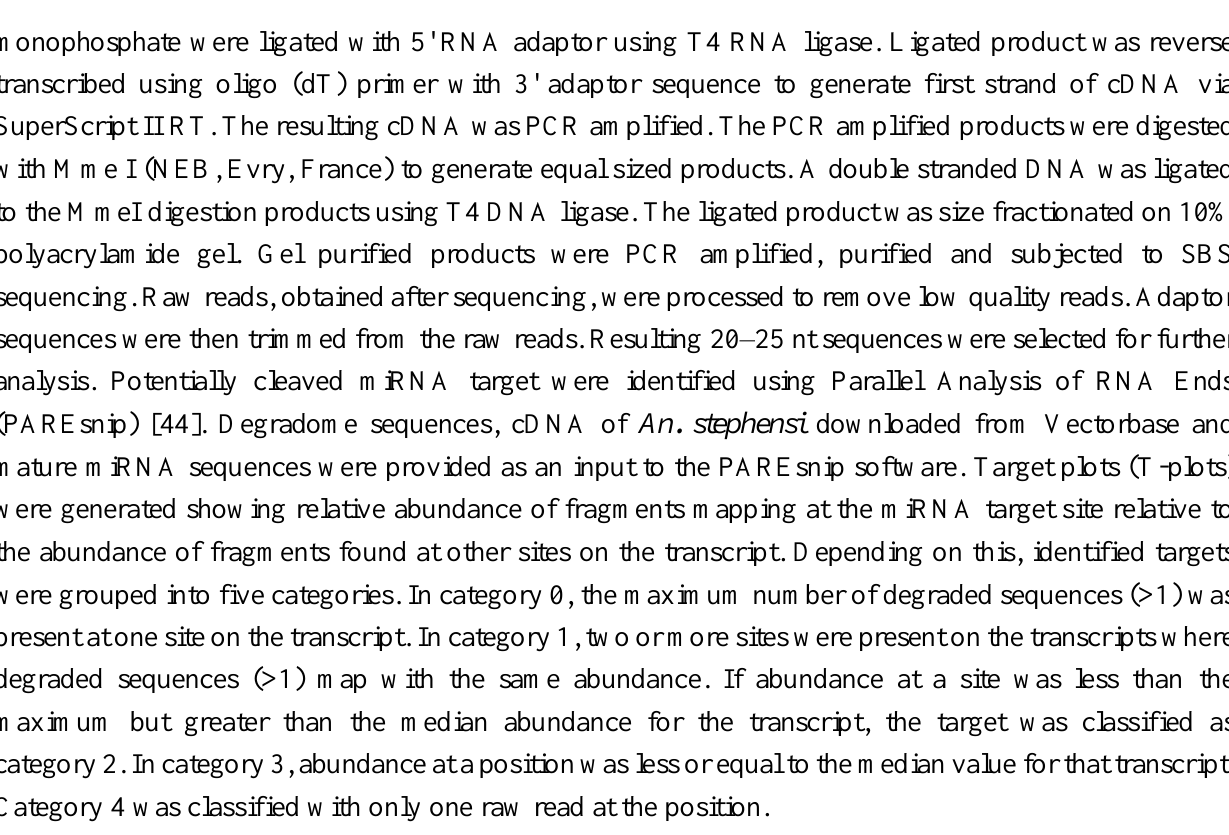
Table S1. List of miRNA targets predicted by RNA hybrid with binding energy of <−20 kcal/mol and p value of